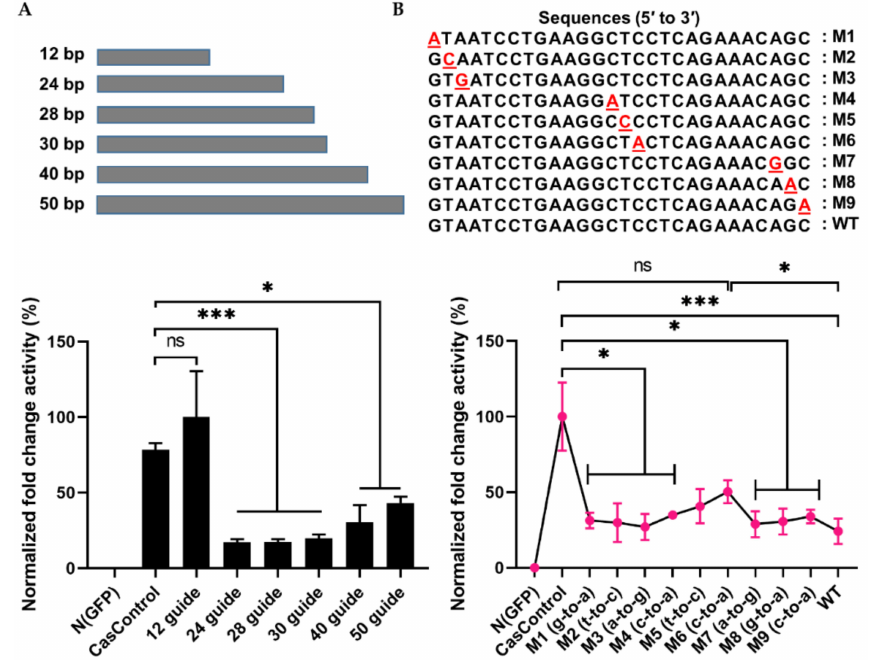
Figure 4. E ff ect of guide RNA design on Cas13a. ( A ) Length of guide RNA: 12, 24, 28, 30, 40, and 50 bp guide RNAs were tested; knockdown started at a length of 24 bp. The FLuc was used as a target transcript while RLuc was used as an internal control to obtain the guide RNA length